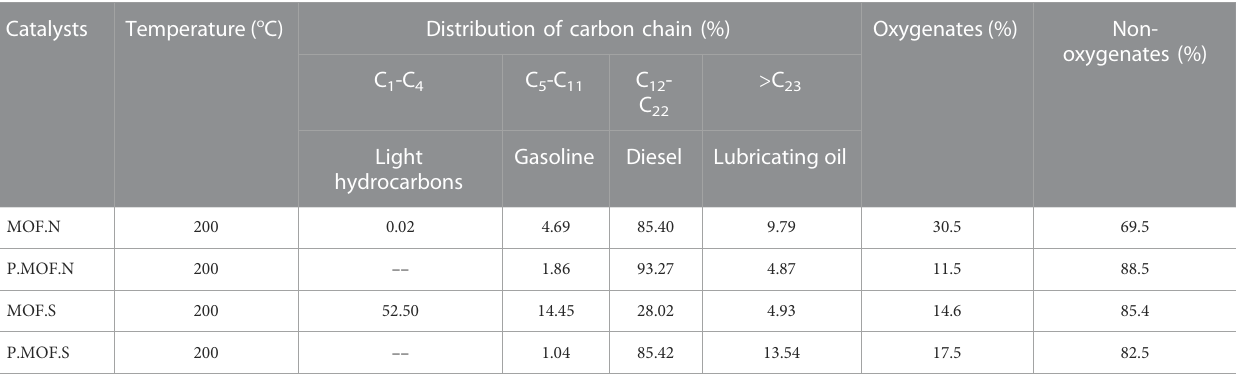
TABLE 2 Carbon chain distribution with oxygenates and